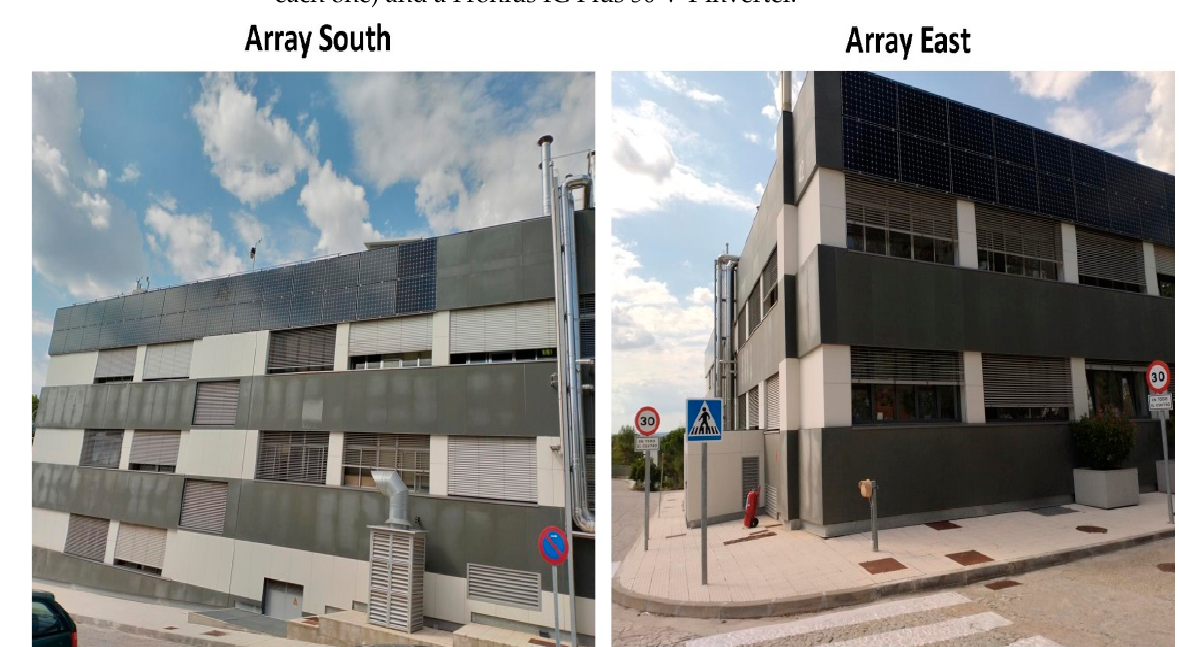
Figure 1. View of the south and east arrays in the Ciemat building.